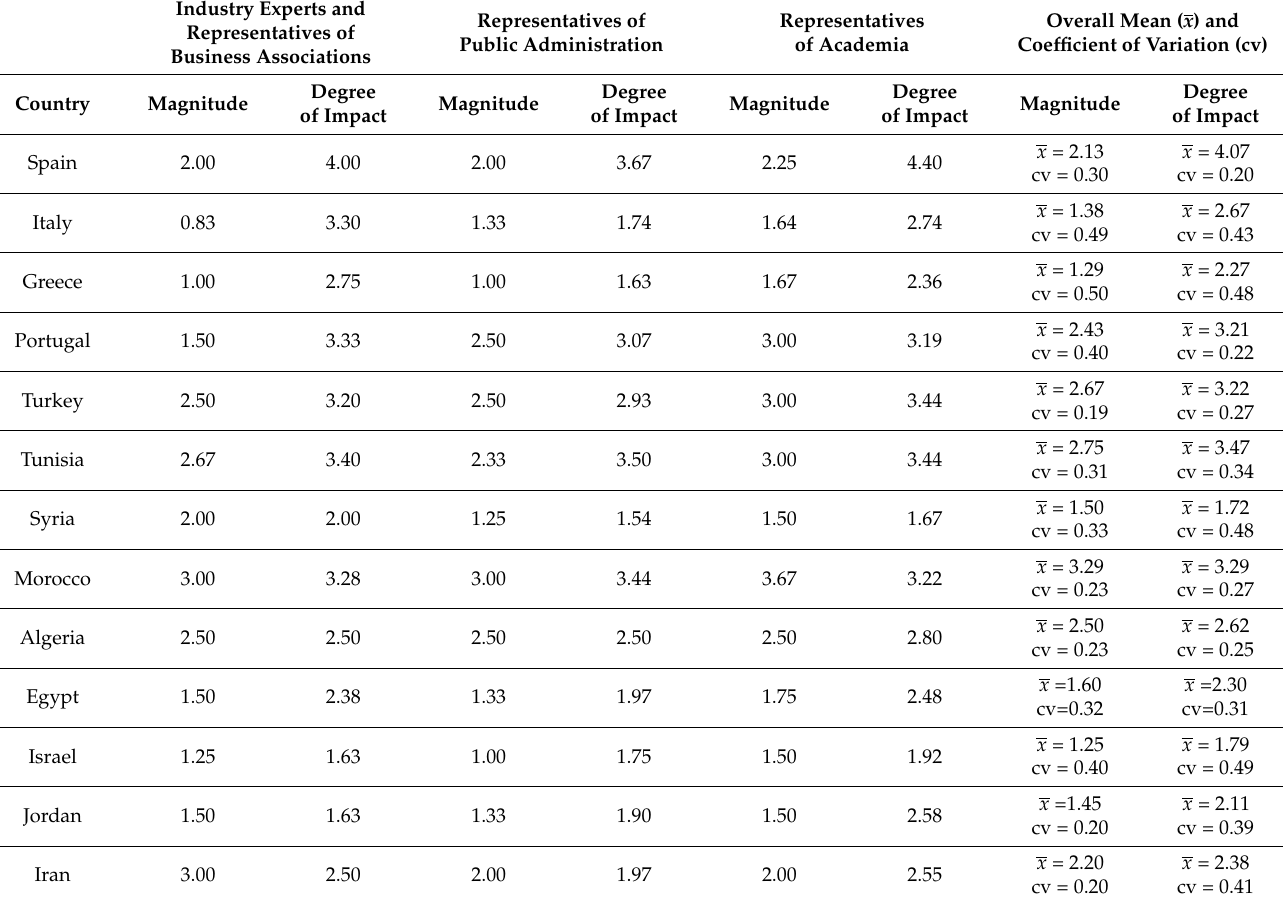
Table A1. Magnitude of the annual increase in the olive oil supply and its degree of impact on Spanish